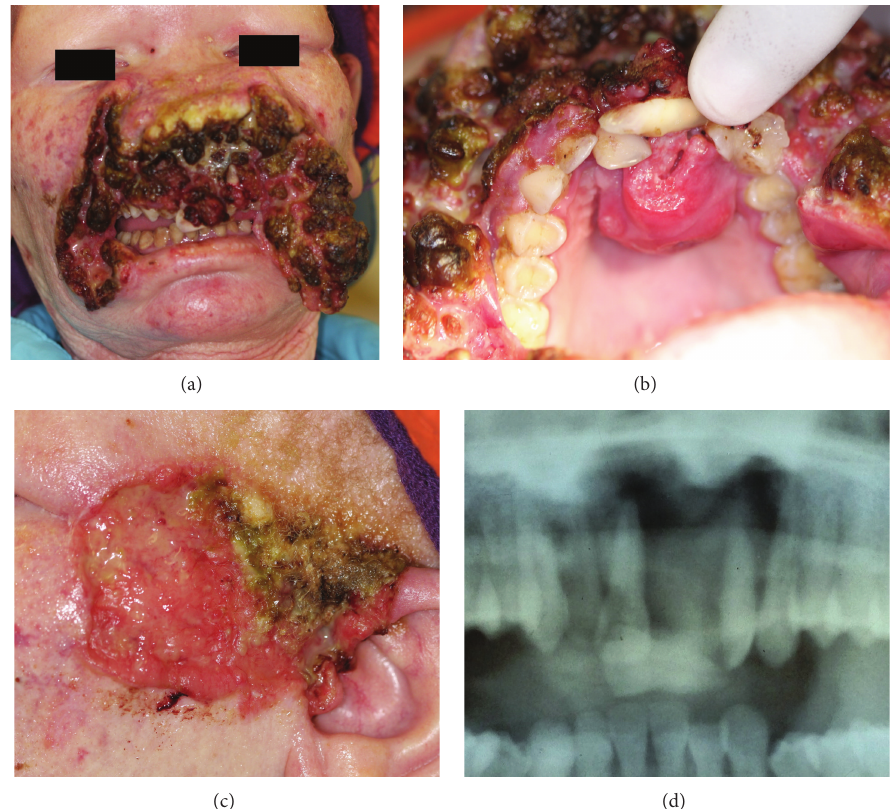
Figure 1: Squamous cell carcinomas (SCCs) in a 38-year-old HIV-seropositive Black albino woman. (a) SCC of the nose, cheeks and the lips, and (b) the labial mucosa and anterior part of the palate. The disease started as a small ulcer on the upper lip 18 months previously, progressing rapidly to involve the mouth and to destroy the lower face. (c) SCC of the left ear and temple started 8 months previously. (d) Panoramic radiograph showing destruction of the anterior maxilla. Histopathologically, the carcinoma was poorly differentiated. The patient died before investigation for metastases could be done. The extensive and striking sunlight-induced malignant facial damage is tragic evidence of the consequence of lack of sun-protection from an early age and of appropriate early medical